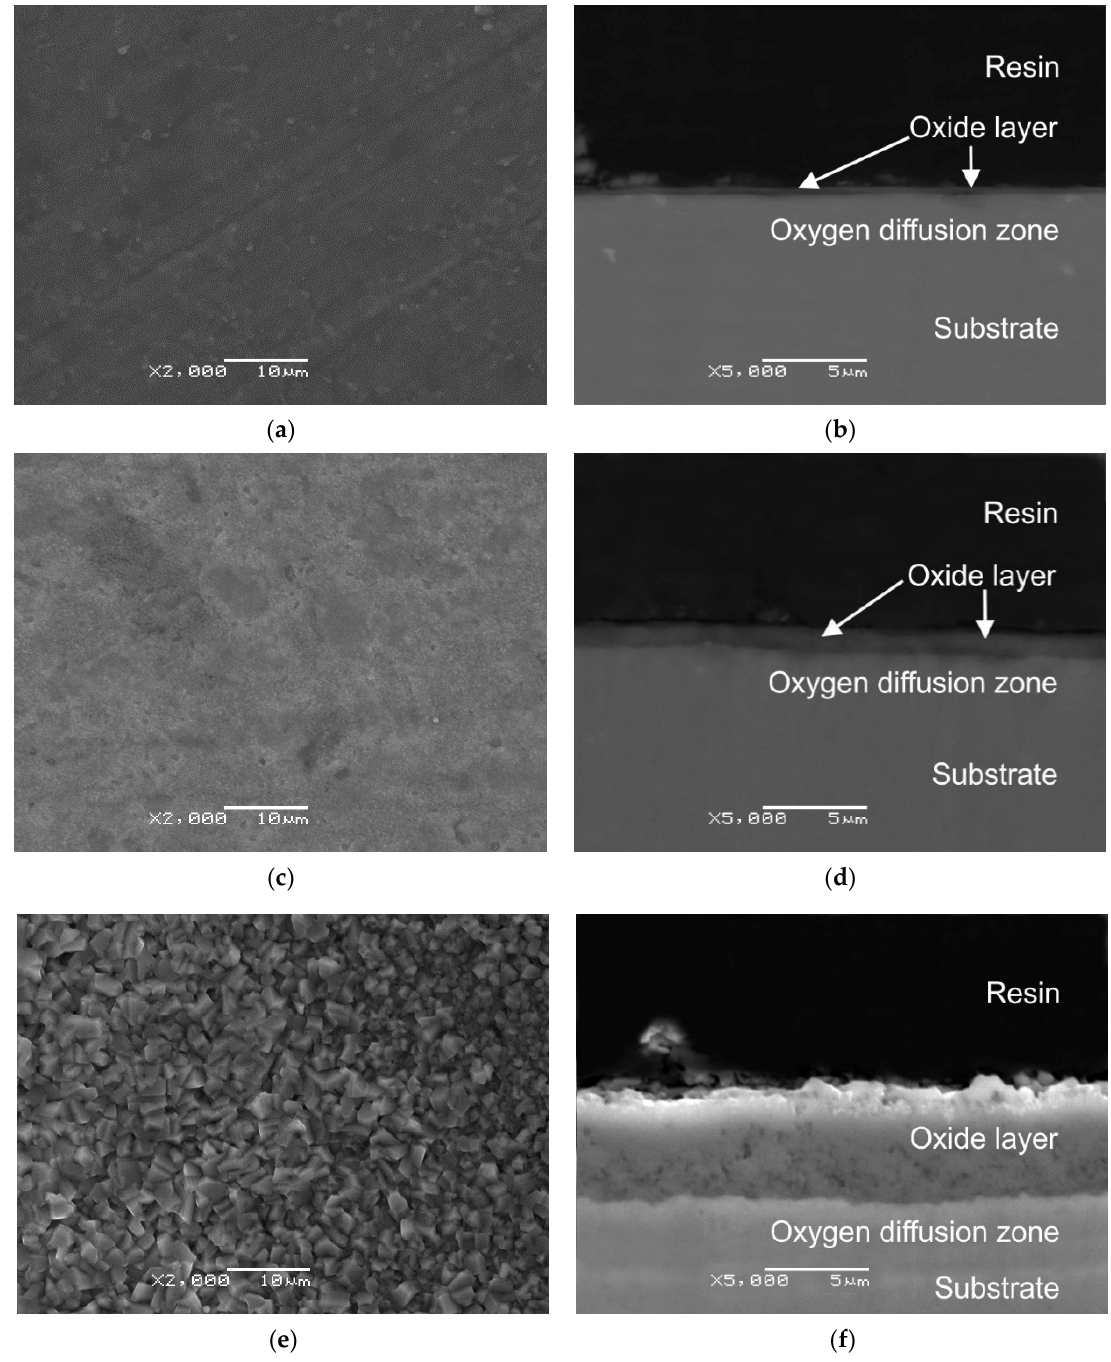
Figure 1. SEM image of the surface morphology and corresponding cross ‐ section of the Ti ‐ 6Al ‐ 7Nb alloy after isothermal oxidation at: 600 °C,( a ) surface morphology, ( b ) cross ‐ section; 700 °C, ( c ) surface morphology, ( d ) cross ‐ section; 800 °C ( e ) surface morphology, ( f ) cross ‐ section.